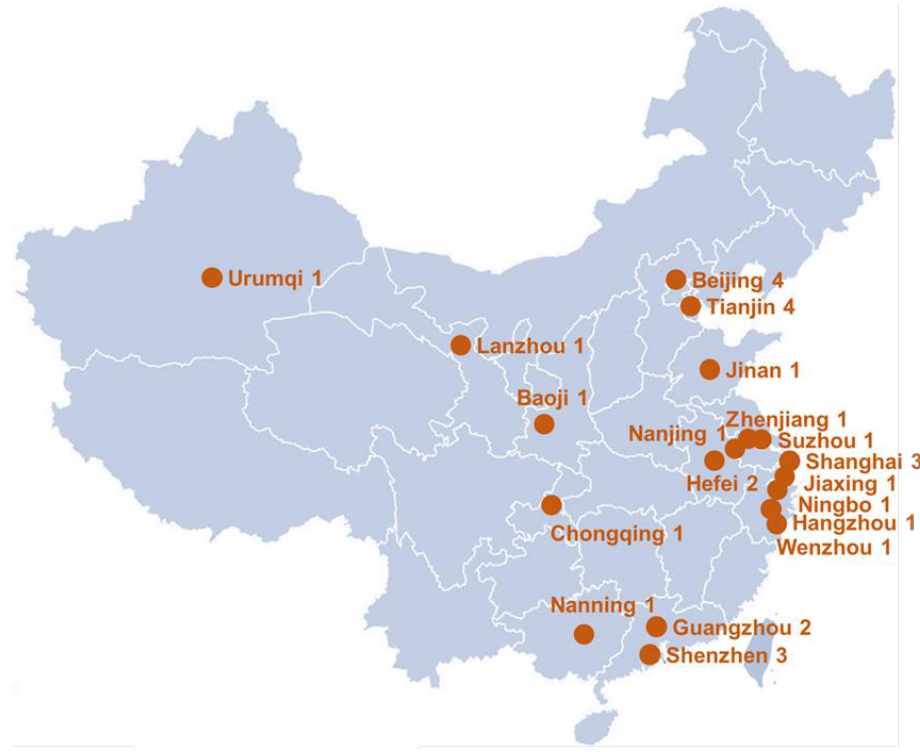
Figure 4. Distribution of urban runoff quality studies in China. The numbers after the city names indicate the number of runoff quality research papers based on the city.